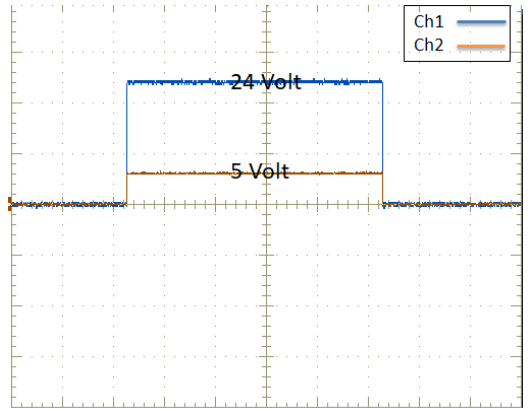
Figure 10 The relation between the input control signal voltage and the excitation solenoid coil